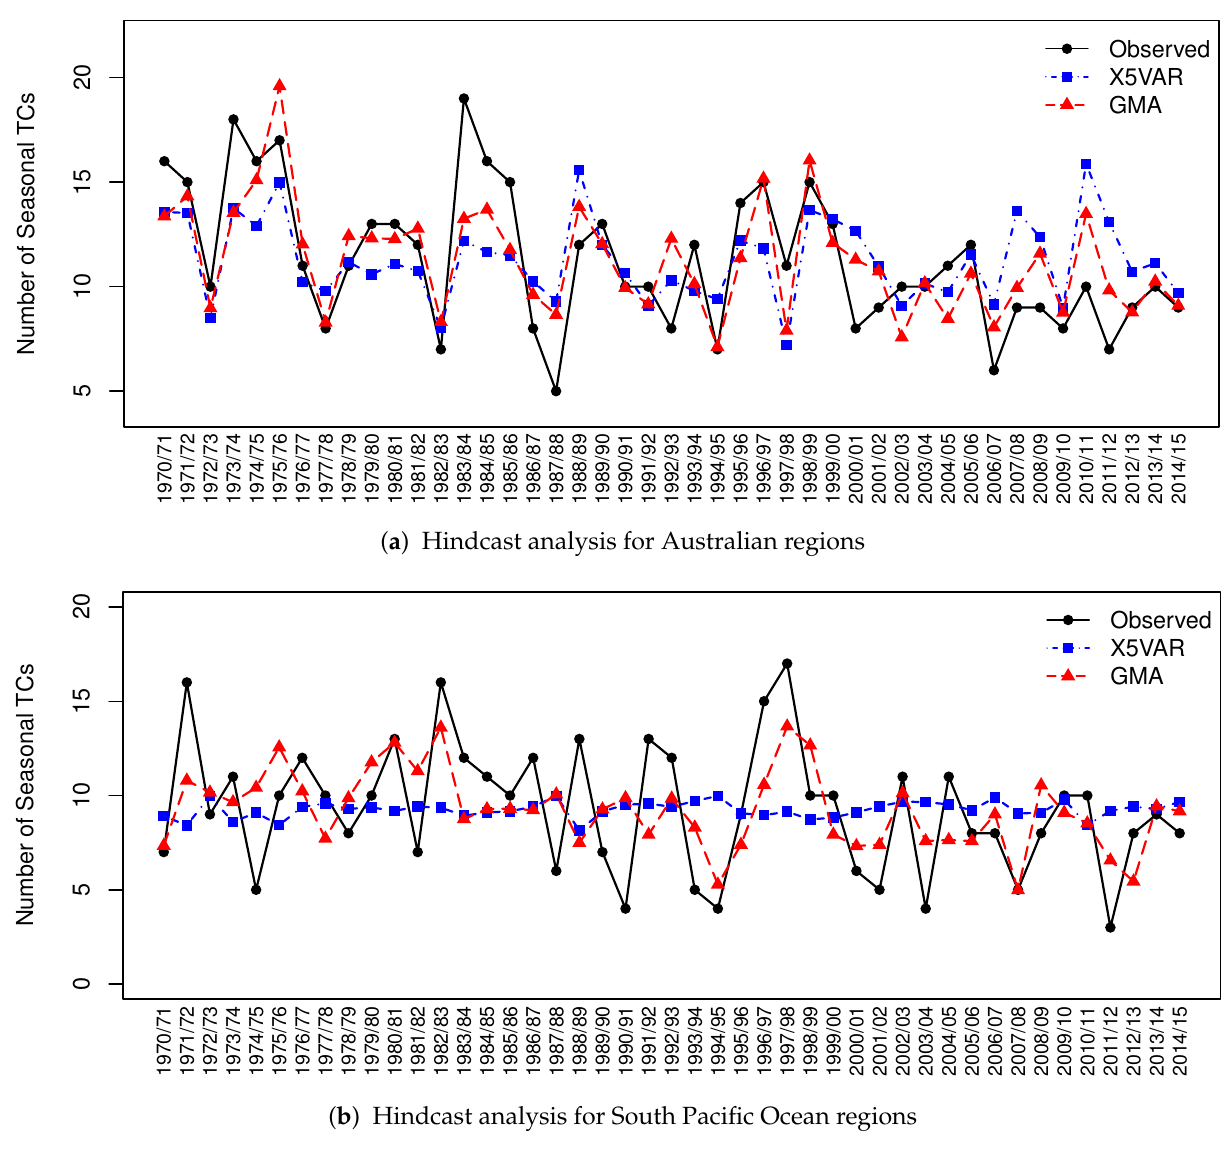
Figure 5. The hindcast analysis results for AR and SPO